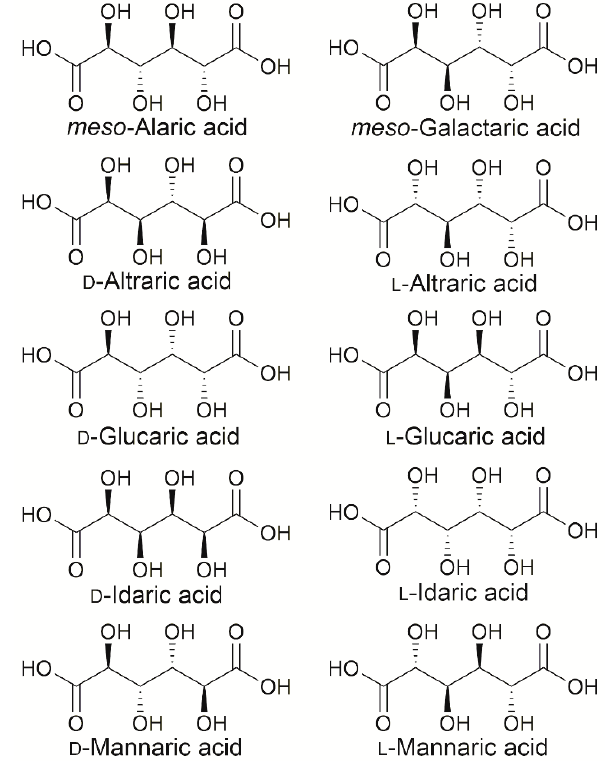
Figure 2. Structures of hexaric acids.